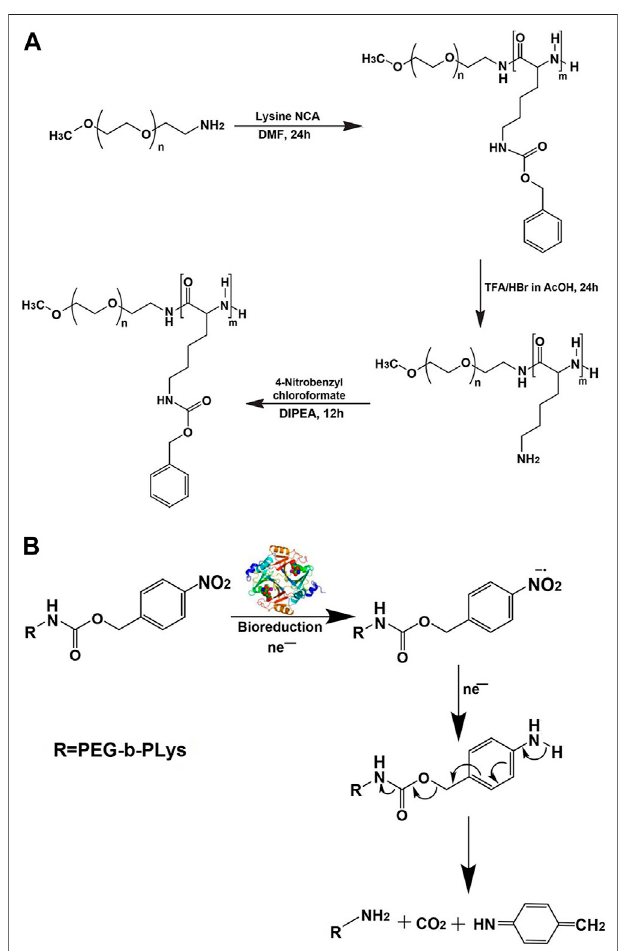
FIGURE 6 | Synthetic route for preparation (A) and mechanism of hypoxic reduction under the nitroreductase of the hypoxia-sensitive copolymer (B) (Thambi et al., 2016). Abbreviation: PEG, poly(ethylene glycol); PLys, poly(L-lysine); DIPEA,